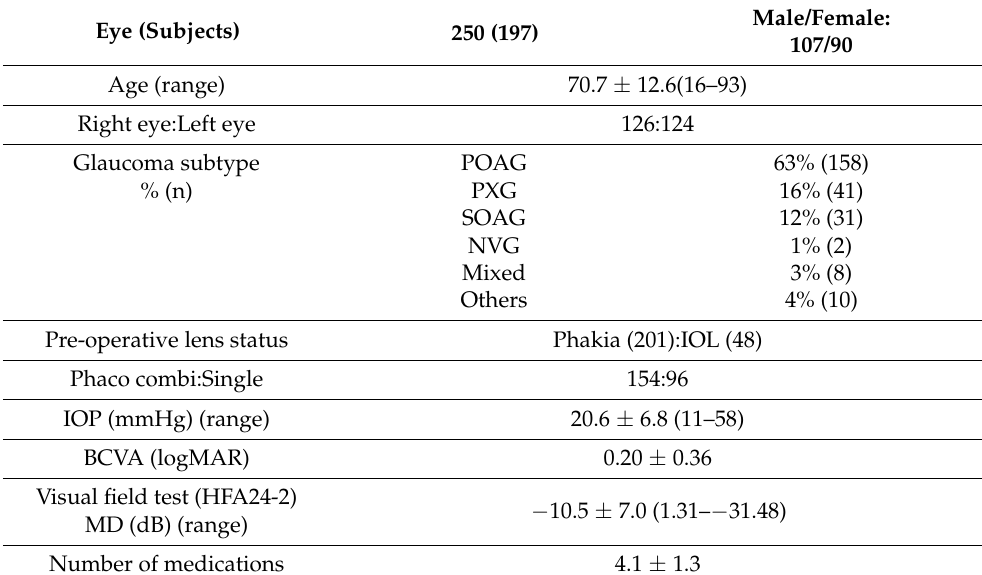
Table 1. Demographics and Preoperative Ocular